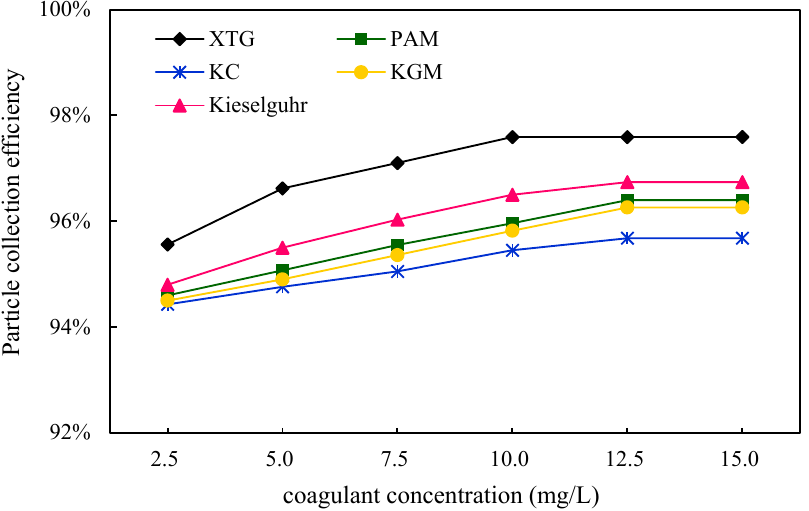
Figure 8. Effect of coagulant concentration on dust removal efficiency.